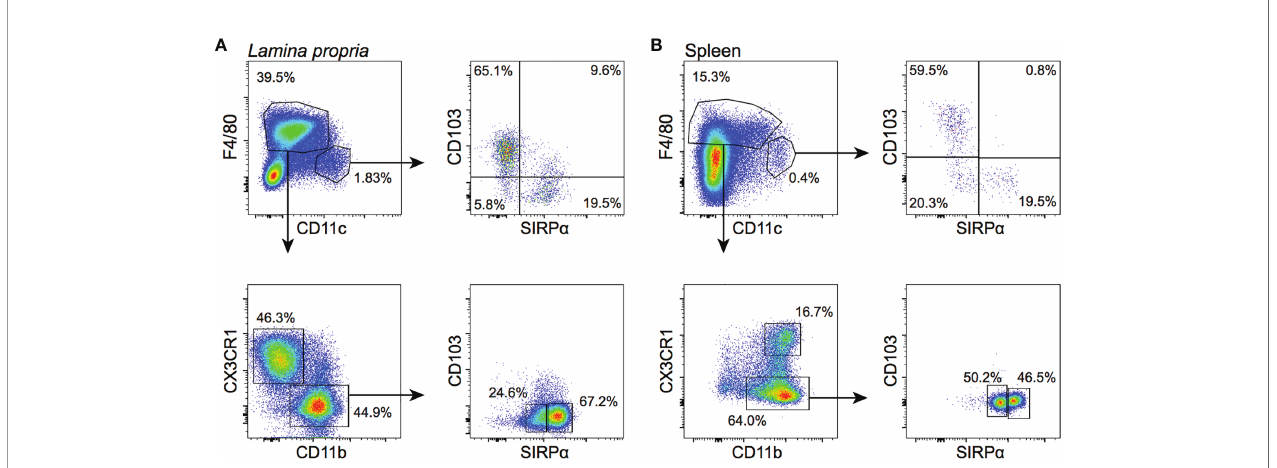
FIGURE 3 | APC subsets in the neonatal LP and spleen. Cells were gated on live CD45 + Lin ‒ B220 ‒ events (see Supplementary Figures 3, 4 for details). (A) In the LP, CD11c hi cDCs (top left panel) are divided into a CD103 + and a SIRP a + subset (top right); F4/80 + macrophages are divided into a CX3CR1 + CD11b ‒ (indicated as CX3CR1 + ) and a CX3CR1 ‒ CD11b + (indicated as CX3CR1 ‒ ) subset (bottom left). The latter comprises a SIRP a lo and SIRP a hi subpopulation (bottom right). (B) In the spleen, CD11c hi cDCs are similarly composed of CD103 + and SIRP a + subpopulations. F4/80 + macrophages are all CD11b + and either CX3CR1 + or CX3CR1 ‒ . The latter comprise a SIRP a lo and SIRP a hi